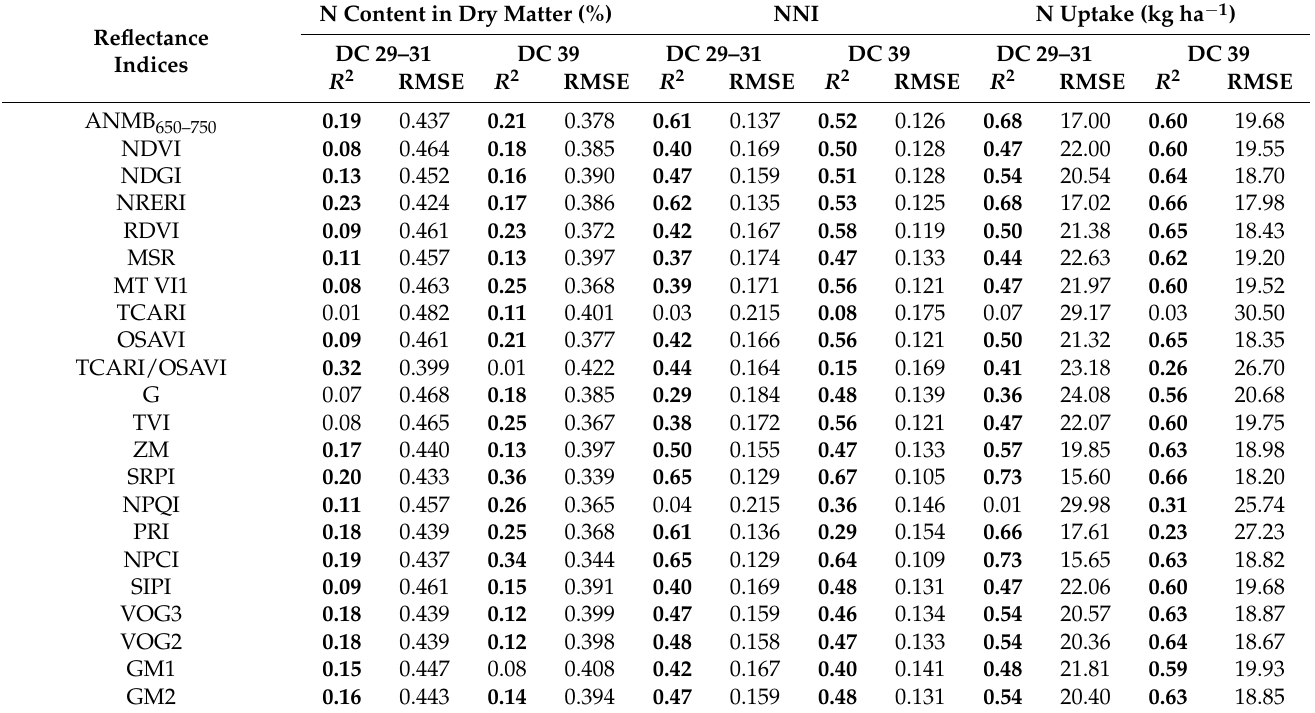
Table 2. Coefficients of determination ( R 2 ) and root mean square errors (RMSE) for linear relationships between reflectance indices and nitrogen status parameters (N content in dry matter, NNI and N uptake by aboveground biomass) at individual growth stages (DC 29–31 and DC 39). Coefficients of determination significant at p < 0.05 are indicated in